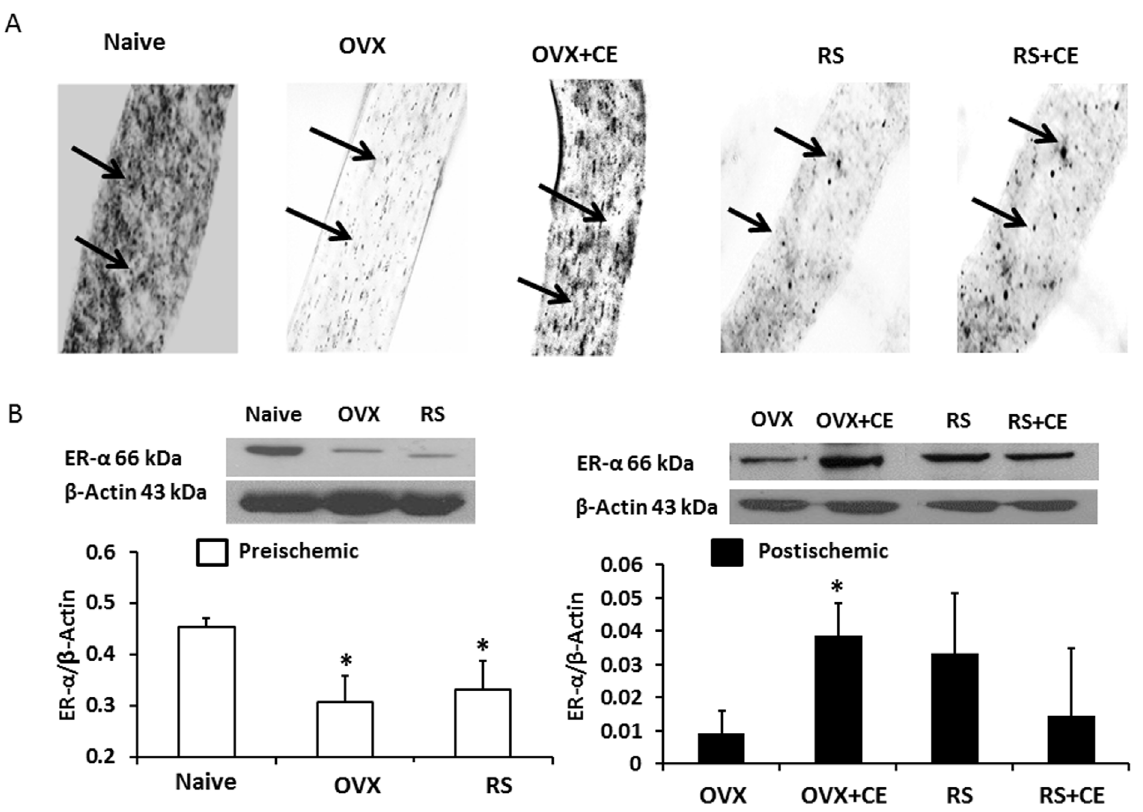
Figure 2. Representative slides obtained from immunohistochemistry staining (A) and Western blotting (B) demonstrate changes in ER- a protein expression in cerebral microvessels isolated from rats at baseline and at 2 hours of reperfusion. Young ovariectomized (OVX) and old reproductively senescent (RS) rats had lower levels of ER- a protein expression in the cerebral microvessels than did young, naive rats. Chronic oral conjugated equine estrogen (CE) treatment resulted in increased expression levels of ER- a protein in OVX, but not in RS rats. Arrows indicate ER- a protein (A). Values of ER- a are expressed as a ratio to b -actin and presented as mean 6 SD; * p , 0.05 vs. corresponding control. Data are from four independent gels, with n=4 per group.